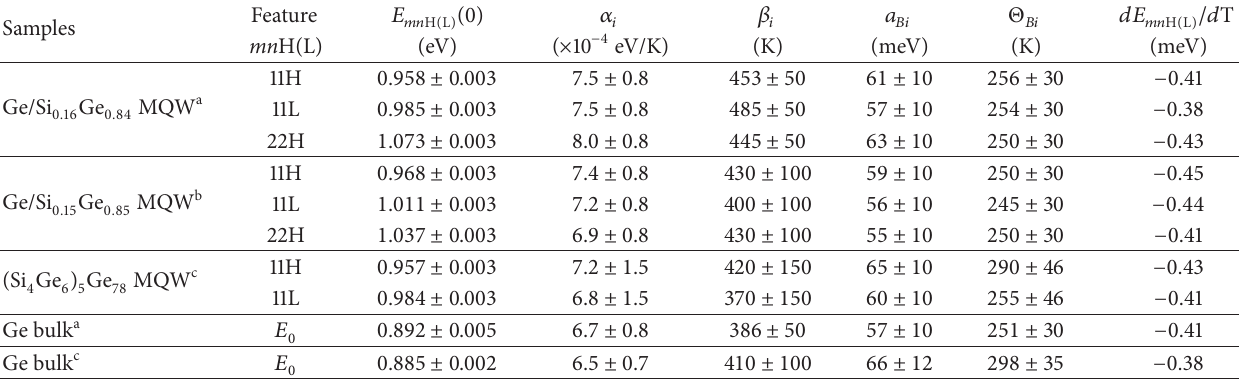
Table 2: Values of the Varshni- and Bose-Einstein-type fitting parameters, which describe the temperature dependence of the mn H(L) transitions of Ge/SiGe MQW. The direct gaps of bulk Ge also included for comparison.